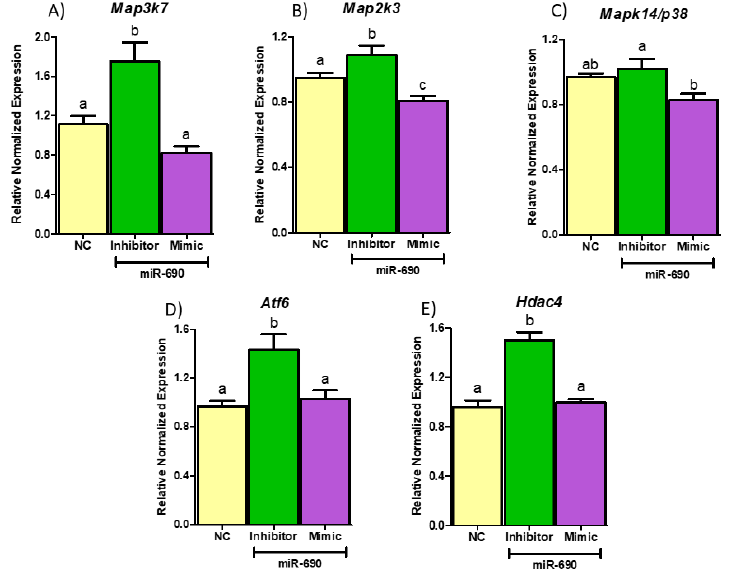
Figure 6. miR ‐ 690 target validation with miRNA mimic and inhibitor treatments. ( A,B ) miR ‐ 690 inhibitor significantly induced expression of mitogen activated protein kinase kinase kinase 7 ( Map3k7 ) and mitogen activated protein kinase kinase 3 ( Map2k3 ) expression, while, as expected, miR ‐ 690 mimic significantly reduced their expression compared to negative control (NC). ( C ) No significant changes were observed with miR ‐ 690 mimic or inhibitor treatments in mitogen activated protein kinase 14 ( Mapk14/p38 ) expression in 3T3 ‐ L1 cells compared to NC groups. ( D,E ) Only miR ‐ 690 inhibitor was able to increase expression of histone deacetylase 4 ( Hdac4 ) and activating transcription factor 6 ( Atf6 ) expression but not mimic compared NC. Common letters on the error bars indicate no significance (e.g., “a” is significantly different from “b” and “ab” indicates no significance compared to “a” and “b”). Data are presented as mean ± SEM ( p < 0.05). ( n = 4).